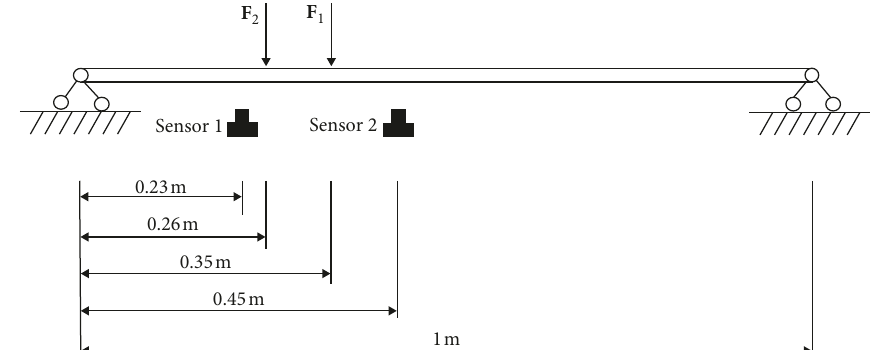
Figure 1: Beam simulation model.